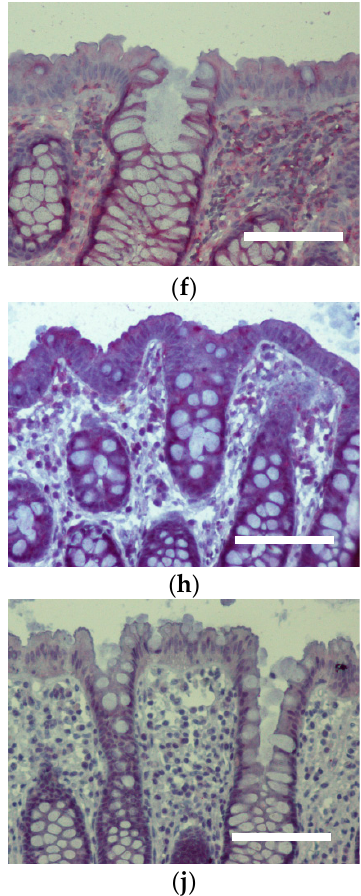
Figure 7. Immunohistochemistry of Th1 cytokines (red) in the colon mucosa of controls and PI-IBS patients of IL-1 β ( a , b ), IL-6 ( c , d ), IL-22 ( e , f ), INF γ ( g , h ) and TNF α ( i , j ), (counterstaining with hematoxylin = violet). Staining for IL-1 β and IL-22 intensified in surface enterocytes in PI-IBS. Bar = 100 µm.